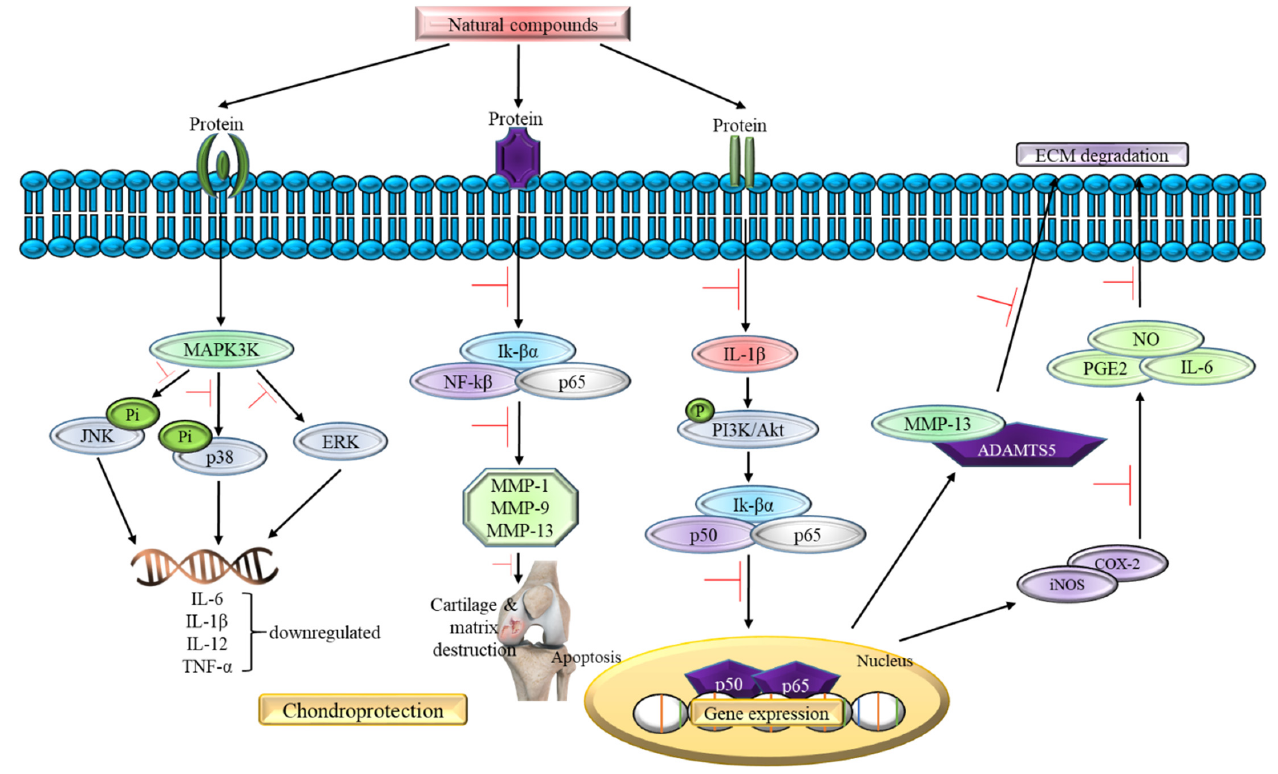
Figure 4. The role of natural compounds in the inflammatory pathway of OA .